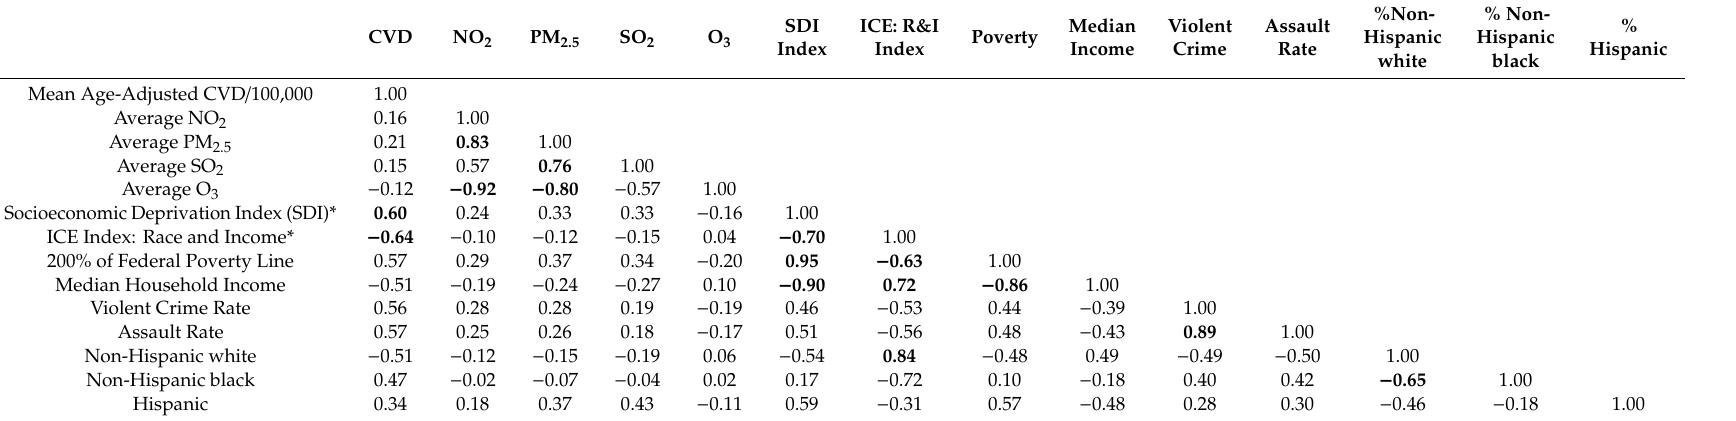
%Non- % Non- SDI ICE: R&I Median Violent Assault % Poverty Hispanic Hispanic Index Index Income Crime Rate Hispanic white black